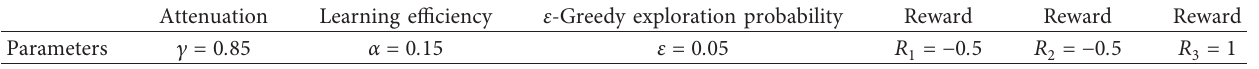
Table 1: The parameters of the path-integral-based reinforcement learning algorithm.